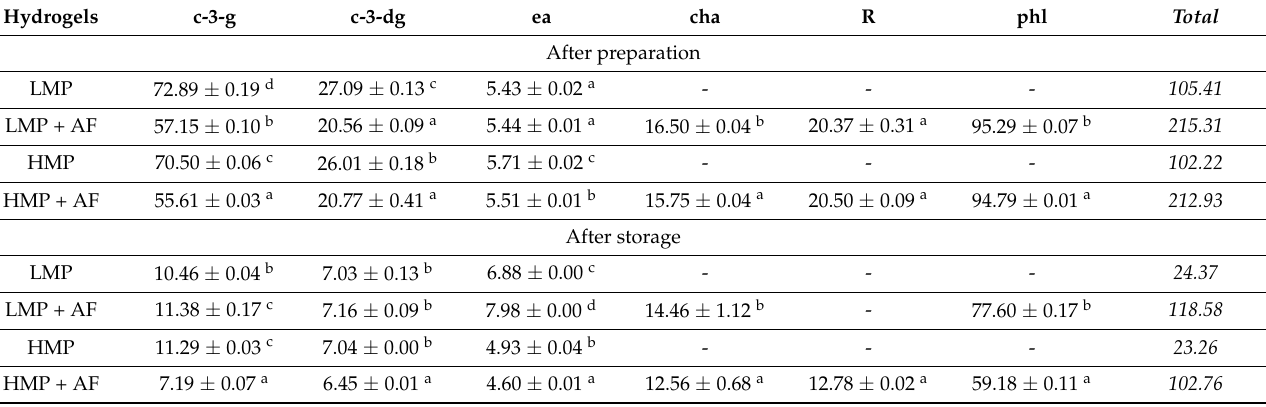
Table 3. HPLC analysis of hydrogels after preparation (mg/kg) and after